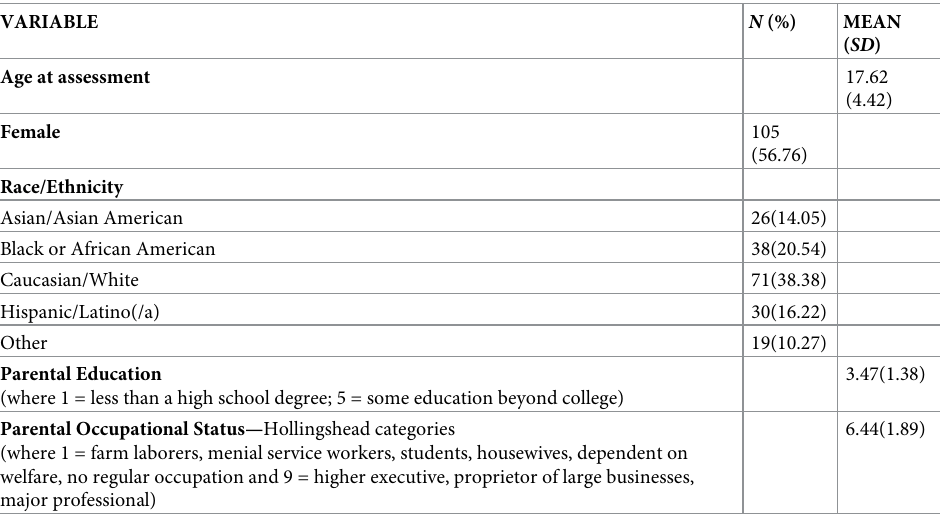
Table 1. Sample demographics ( N = 185